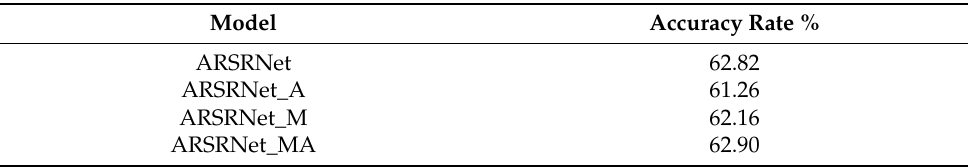
Table 7. Comparison of attention modules on MSC0C0